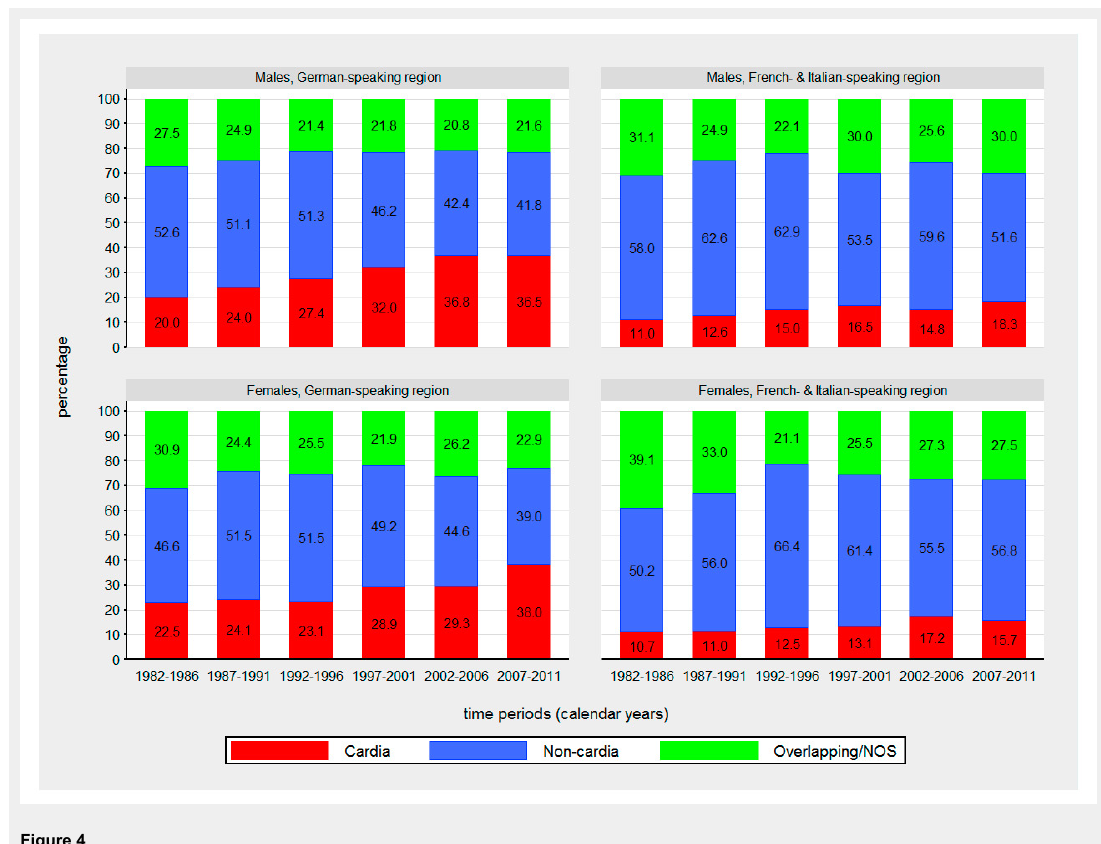
Figure 4 Time trends in proportions of gastric cancer cases by sex, anatomical location and language region from 1982 to 2011. NOS = not otherwise